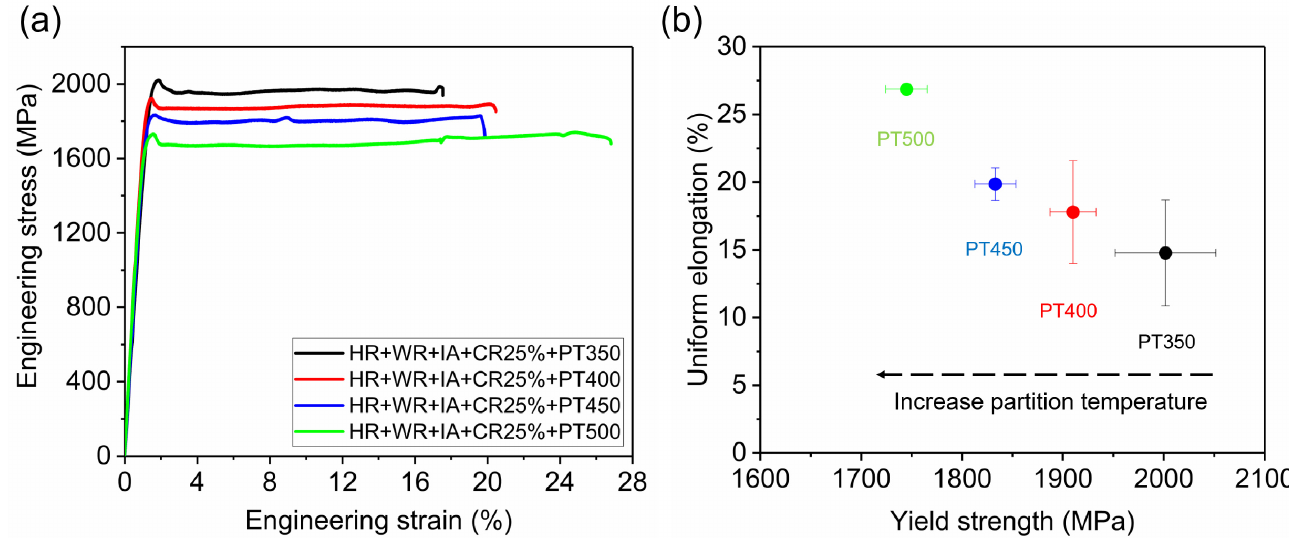
Figure 11. ( a ) Engineering stress–strain curves of the HR + WR + IA + CR25% + PT samples with the partitioning temperatures (PT) set as 350 °C, 400 °C, 450 °C, 500 °C, respectively. ( b ) Uniform elongation versus yield strength for samples in ( a ), the yield strength is determined as the upper yield point for D&P samples, the colors in ( b ) are in consistent with colors in ( a ).